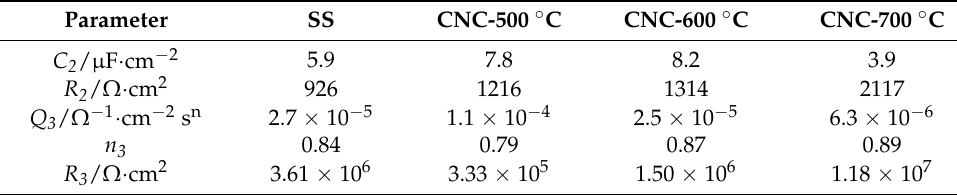
Figure 8. ( a ) Nyquist representation of electrochemical impedance spectra, and ( b ) linear polarization curves recorded on chosen nanostructured carbon electrodes immersed in synthetic domestic wastewater. Table 2. Selected parameters calculated on the basis of the EEC.